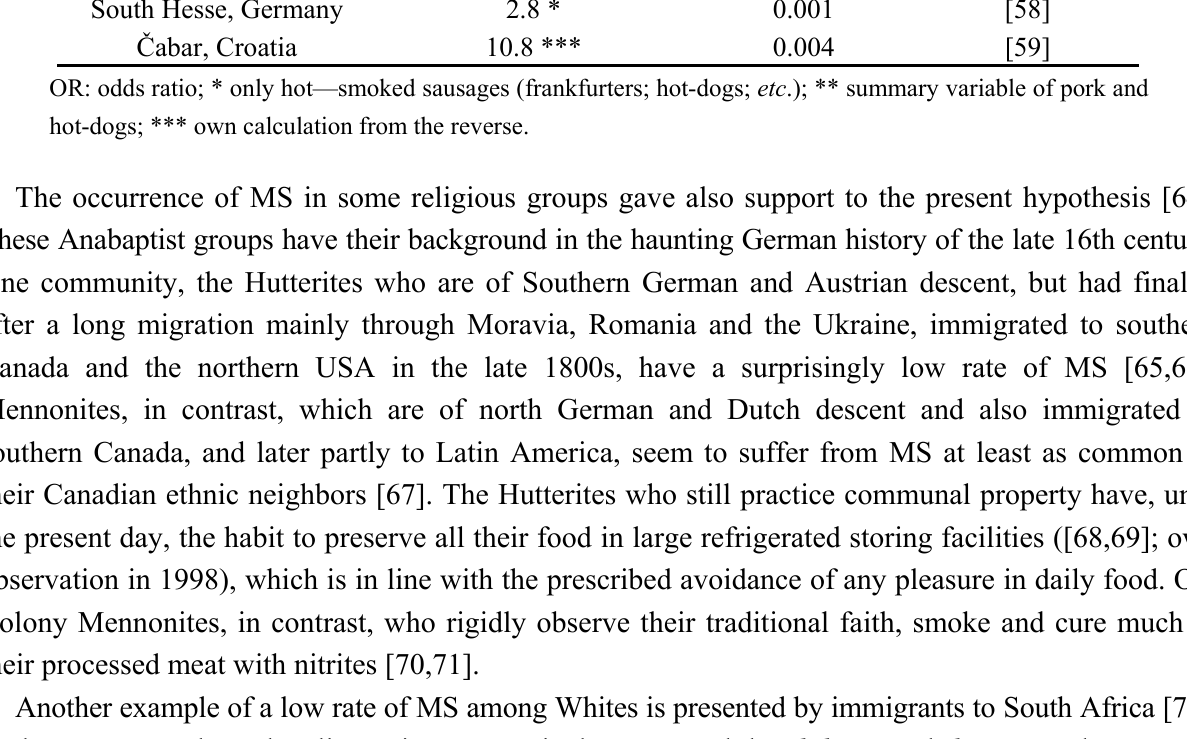
OR: odds ratio; * only hot—smoked sausages (frankfurters; hot-dogs; etc .); ** summary variable of pork